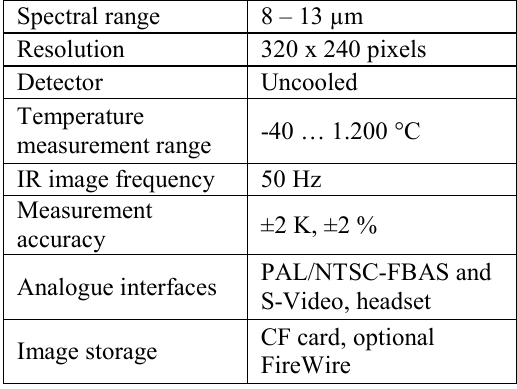
Table 1. Technical data of IR Jenoptic – Variocam [6]